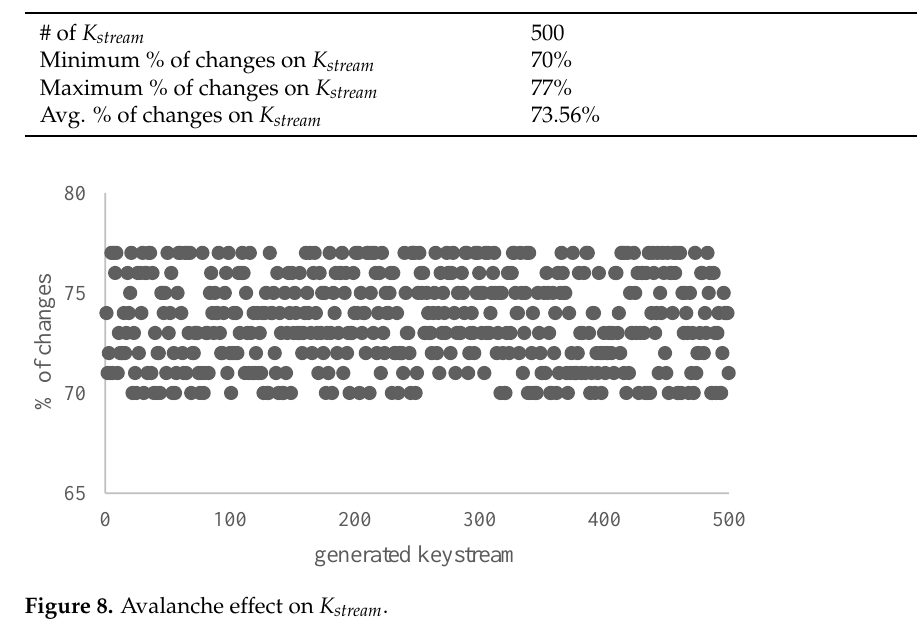
Table 5. Avalanche effect on K stream .